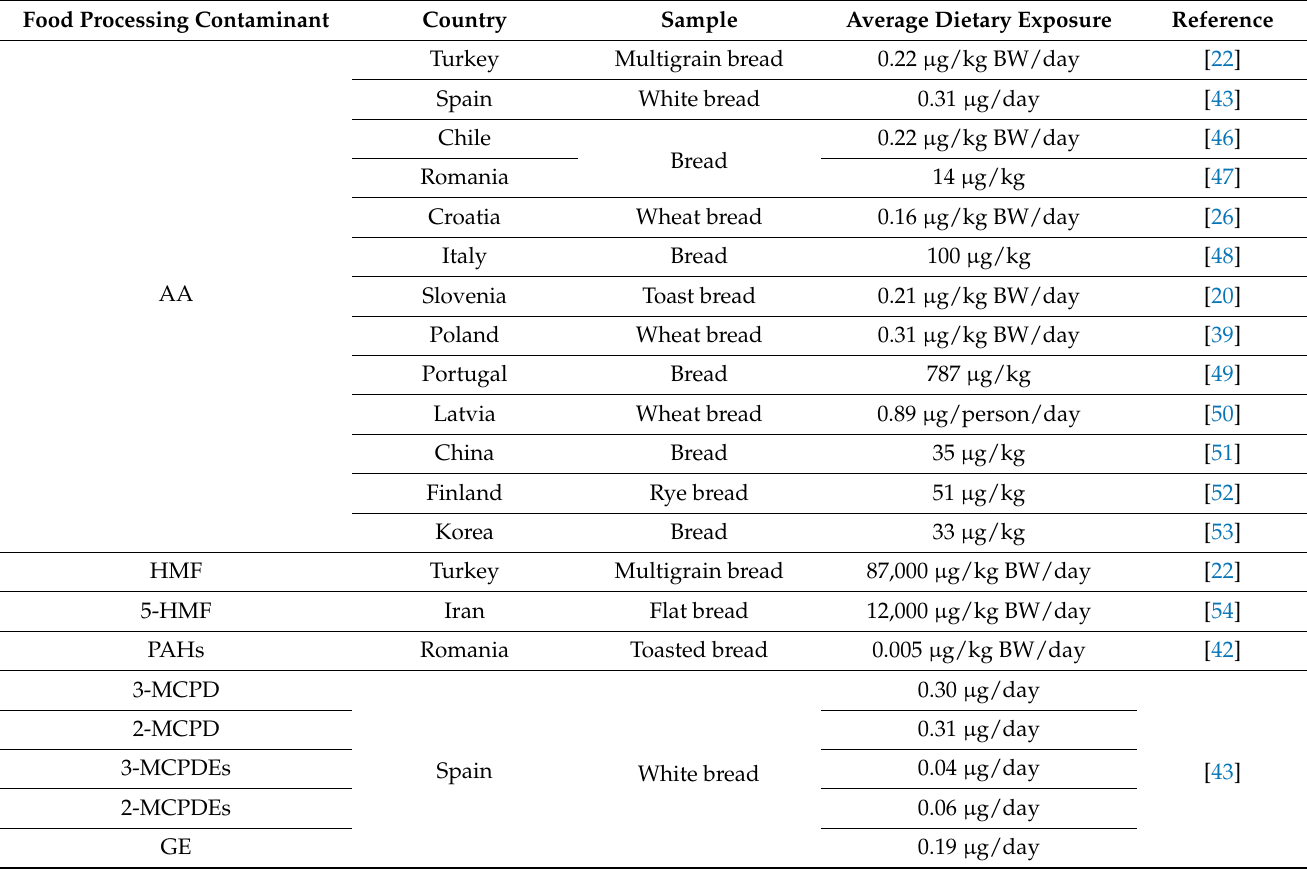
Table 2. Dietary exposure to food processing contaminants in bread products in various countries. Food Processing